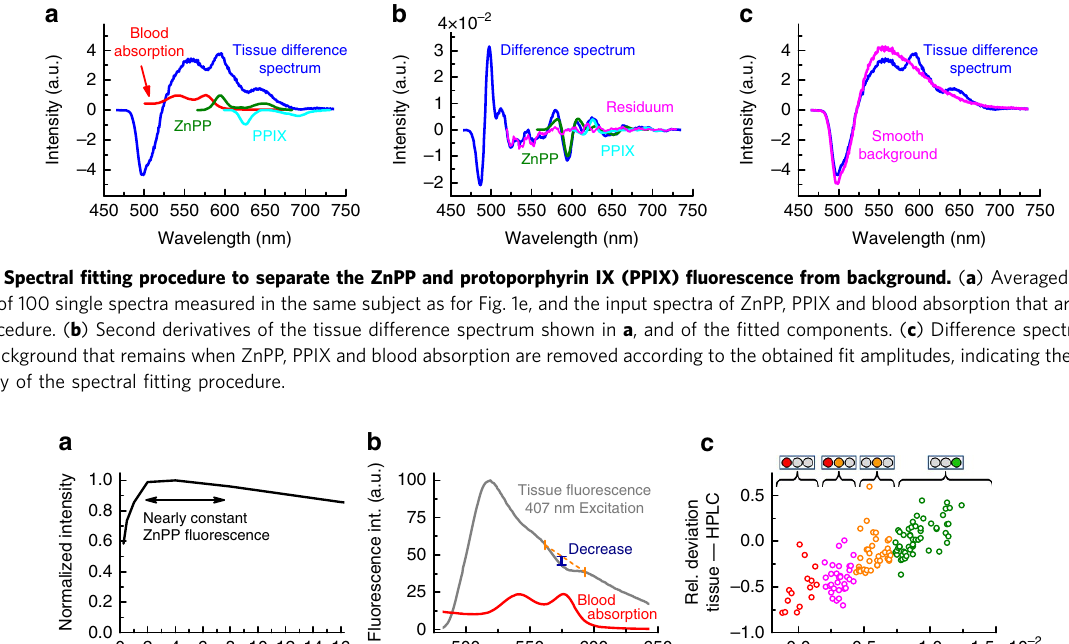
Supplementary Fig. 7 for the correlation and a Bland–Altman plot).